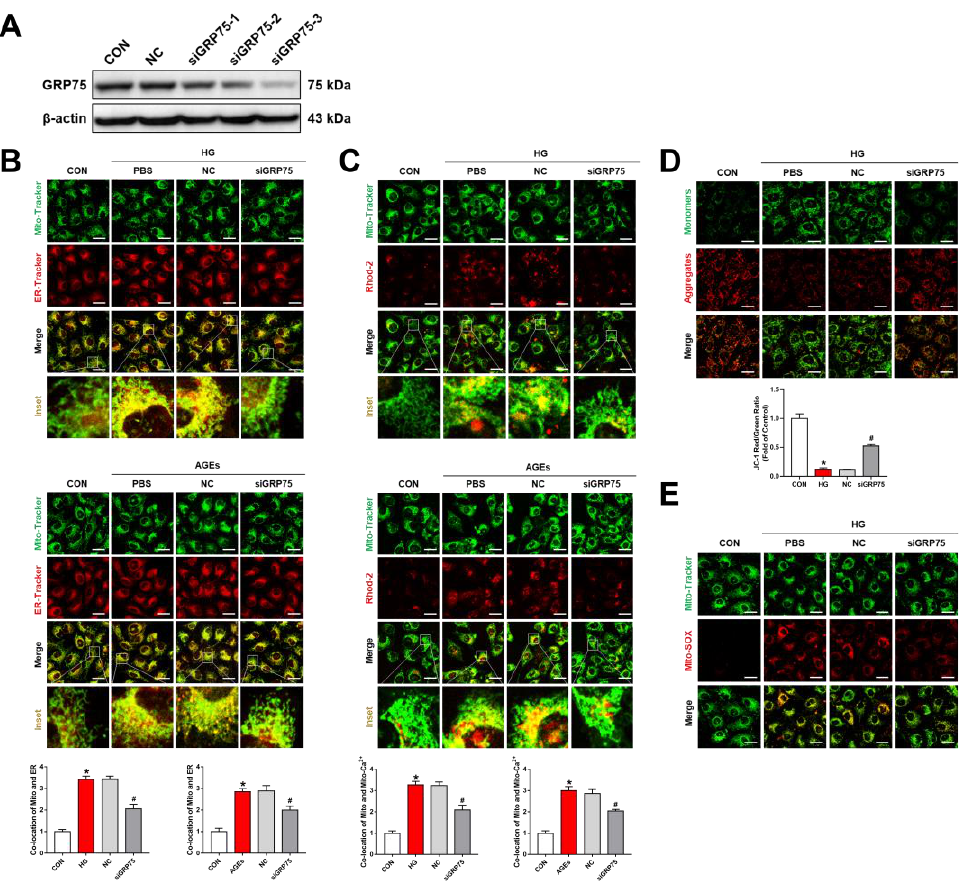
Figure 2. Inhibition of GRP75 rescued ER–mitochondria coupling and mitochondrial dysfunction in HG or AGE-induced RMECs. ( A ) RMECs were transfected with GRP75 siRNA with a 48 h period, and the transfection efficiency was estimated through Western blot. ( B , C ) RMECs were transfected with GRP75 siRNA for 48 h and stimulation with HG (33 mM) or AGEs (200 μg /mL) for 48 h. Mito-Tracker Green (200 nM, 30 min), ER-Tracker Red (1 µ M, 30 min), and Rhod-2 AM (2 µ M, 30 min) were used as mitochondrial, ER, and mitochondrial Ca 2+ markers, respectively . Scale bars = 25 μm. ( D ) Mitochondrial membrane potential assessment was performed by JC-1 staining. The ratios of red fluorescence (JC-1 aggregates) and green fluorescence (JC-1 monomers) were quantified. Scale bars = 25 μm. ( E ) MitoSOX™ Red (5 μM, 10 min) and Mito-Tracker Green (200 nM, 30 min) were used to detect mitochondrial ROS co-localization with mitochondria. Scale bars = 25 μm. Results are displayed as means ± SD. * p < 0.05 vs. control group, # p < 0.05 vs. HG or AGEs group.